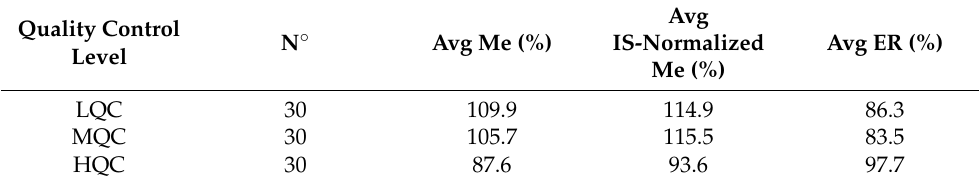
Table 4. Average (Avg) Matrix effect (ME%) and Recovery (ER%) of DBV measured at different concentration levels.